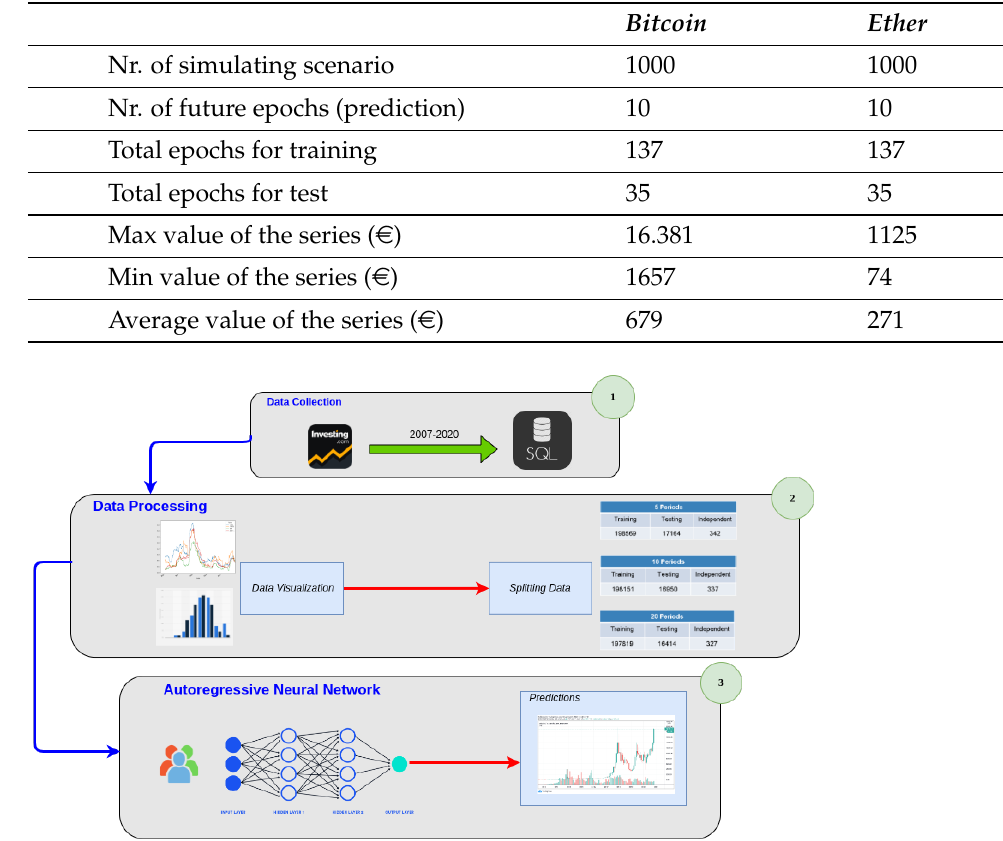
Table 1. ARNN time series parameters and main statistics.